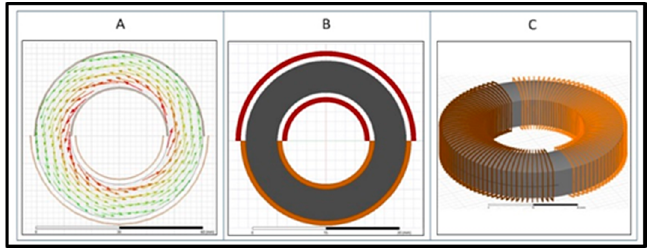
Figure. 5. The 180° conventional ( A ) flux pattern in core; ( B ) 2D model; ( C ) 3D model.